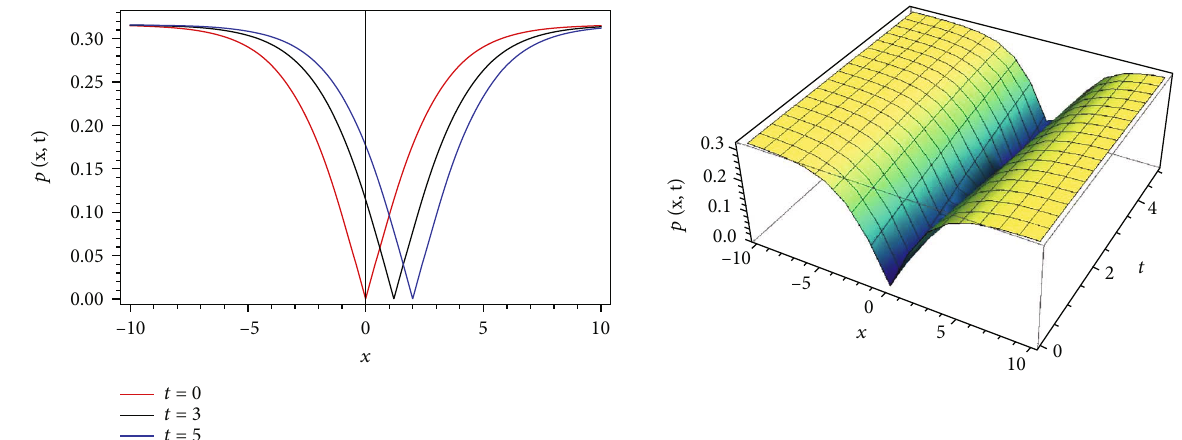
: 1, β : 1, γ : 1, k = 0 : 5, α = 0 : 4, ω j = 0 j = 0 j = 0